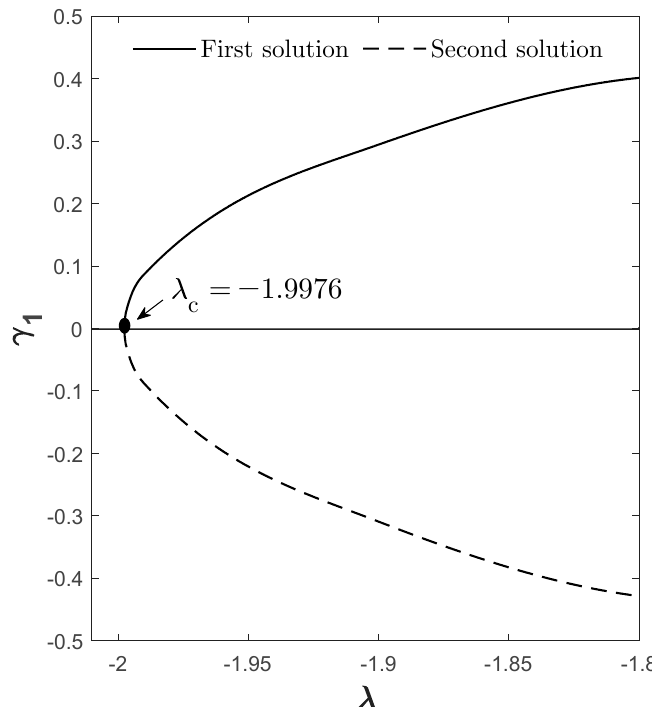
γ for selected λ when Figure 20. Plots of γ 1 for selected λ c when N = Rd = Sc = Sr = 1, φ 2 = 0.01, Du = 0.03, and c 1